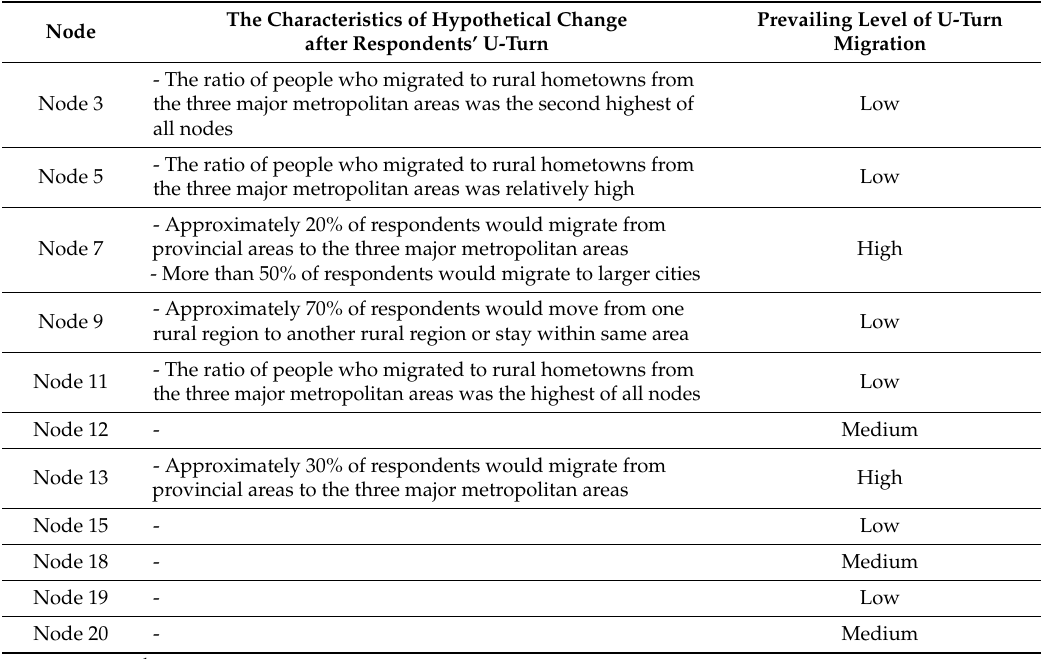
Table 10. Notable characteristics of the hypothetical change after respondents’ U-turn of each node. The Characteristics of Hypothetical Change Node after Respondents’